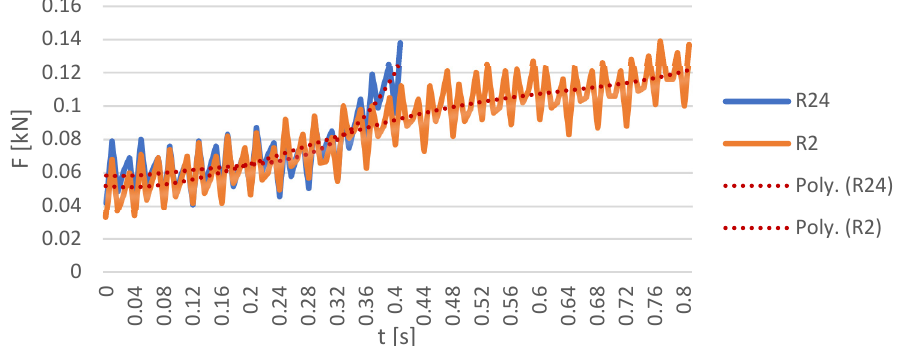
Figure 6. Superposition of the forces’ evolution at the initial and final repetitions—10 kg load.